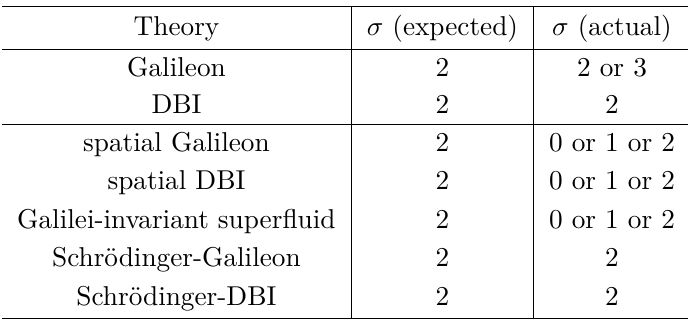
Table 1 . Overview of type A 1 and type B 2 EFTs of a single NG boson along with the soft scaling parameter σ of their scattering amplitudes. The first two lines correspond to the usual Lorentz- invariant EFTs of a single real massless scalar. The rest of the table lists the EFTs reviewed in this section. The second and third column displays respectively the prediction for σ based on the presence of redundant symmetry, and the actual value of σ extracted from numerical study of tree-level scattering amplitudes. Appendix A details the setup of the numerical analysis. See the text for an explanation of the alternatives in the third